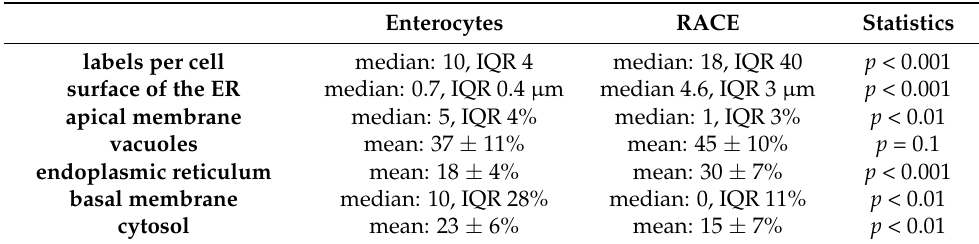
Figure 2. Higher abundance of ERp57 within the ER of RACE and control patients. ( A ) High amounts of ERp57 within vacuoles, the ER and the cytosol of enterocytes. Only small proportions were detected at the apical and basolateral membrane. ( B ) High amounts of ERp57 within vacuoles, the ER and the cytosol of RACE. Higher detection of ERp57 within the ER of RACE displayed as absolute count of gold particles labelling ERp57. Reduced detection of ERp57 within the ER of RACE in CD biopsies. ( C ) ERp57 concentration trended to be higher in the ER of RACE compared to enterocytes and in the NCD group compared to CD group. A/B) Graphs display the values from each individual, red line = median. ( C ) Red line = median. ( D ) Data are shown as median and 97% CI, n = 50 in each group. * p < 0.05, ** p < 0.01, *** p < 0.001. RACE show a higher amount of ERp57 as observed by an increased number of gold Table 1. Intracellular distribution of ERp57 in enterocytes and particles per cell. Increased volume of the ER in RACE compared to enterocytes, but with- out a difference between CD and NCD patients. Higher presence of ERp57 within the ER